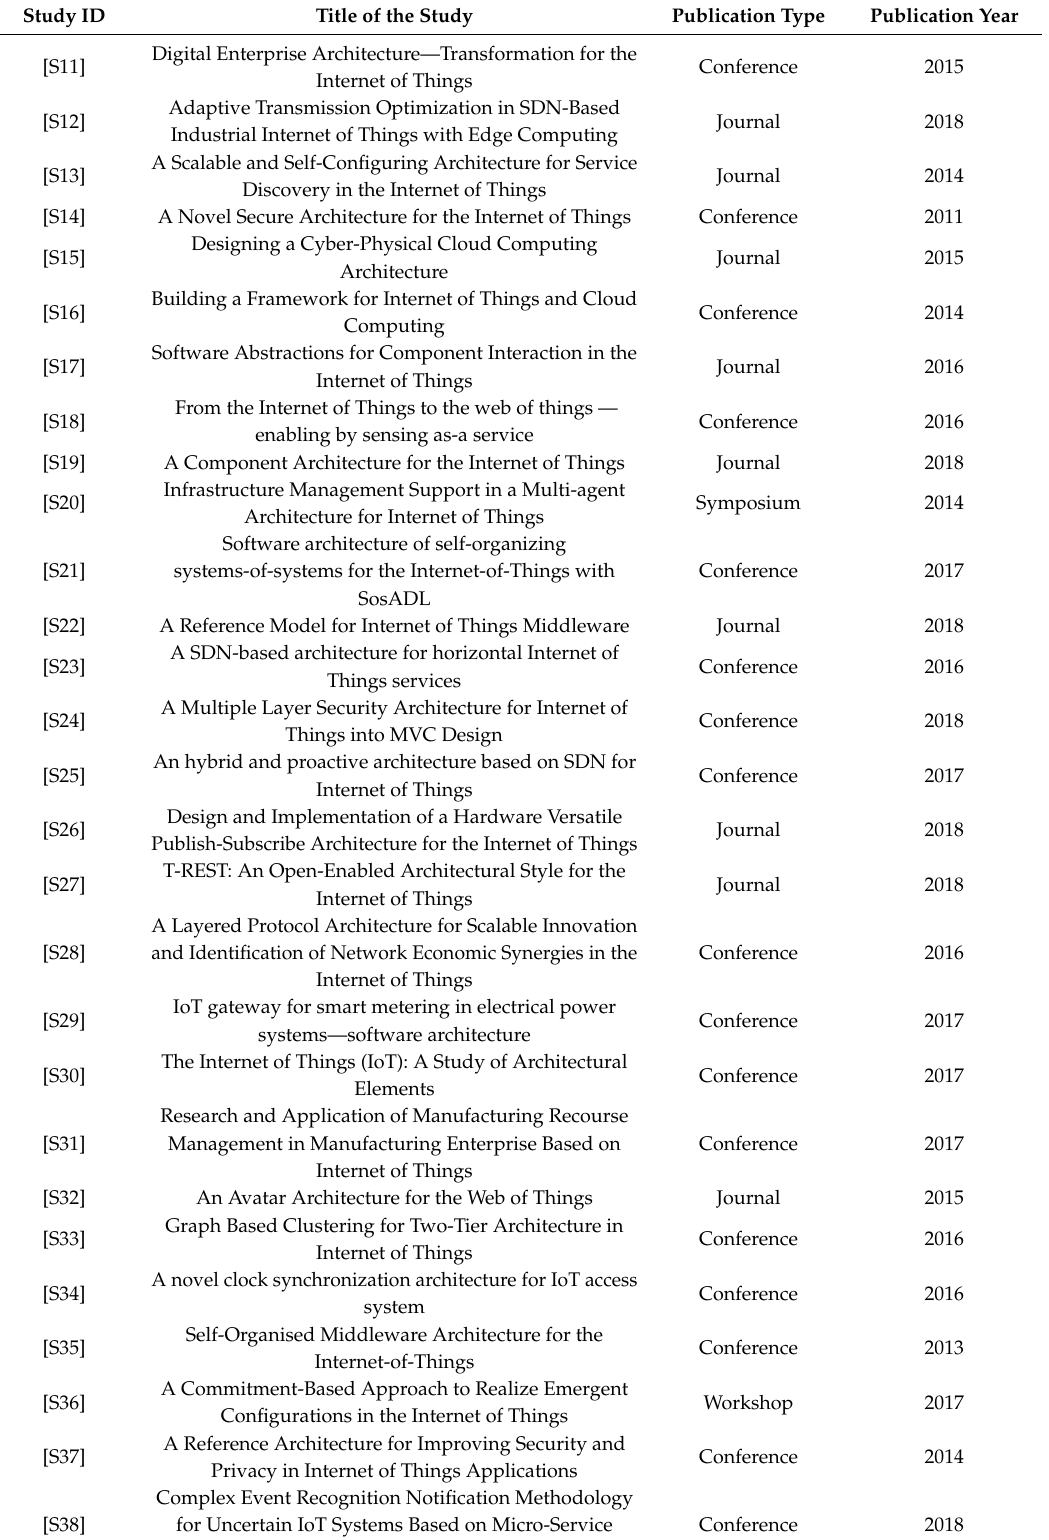
List of Qualitatively Selected Studies (Published Research) for the Systematic Mapping